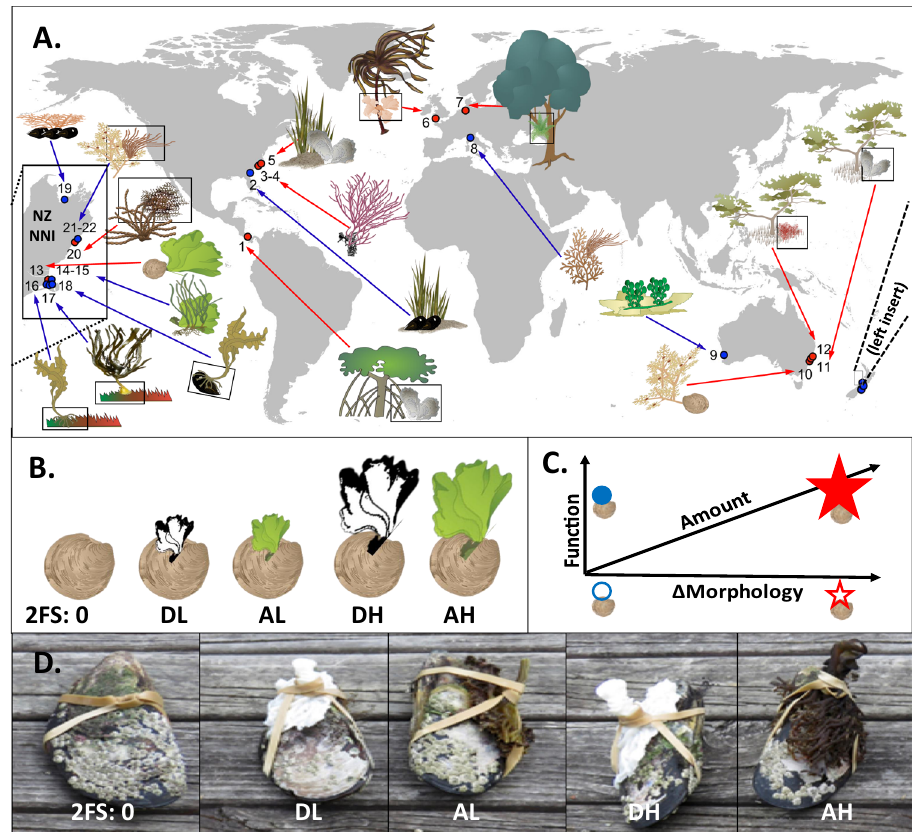
Fig. 1 Locations and experimental design of 22 geographically distributed facilitation experiments testing for effects of habitat heterogeneity on biodiversity. A Map showing the distribution of 22 analogous facilitation cascade experiments numbered from west to east beginning in North America. The insert map on the left is a close-up of New Zealand Northern South Island (NSI NZ). B Schematic diagram of experiment 13 shows the control